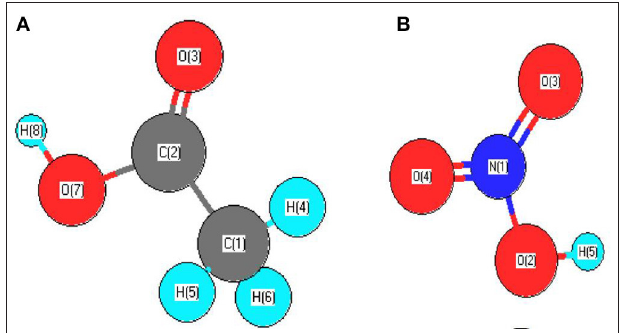
FIGURE 1 | SEM images of (1A) 9IMPNiA-B and (1B) 12IMPNiN-B spent catalysts (550 ◦ C). SEM images of (2A) 9IMPNiA-B and (2B) 12IMPNiN-B fresh catalysts.